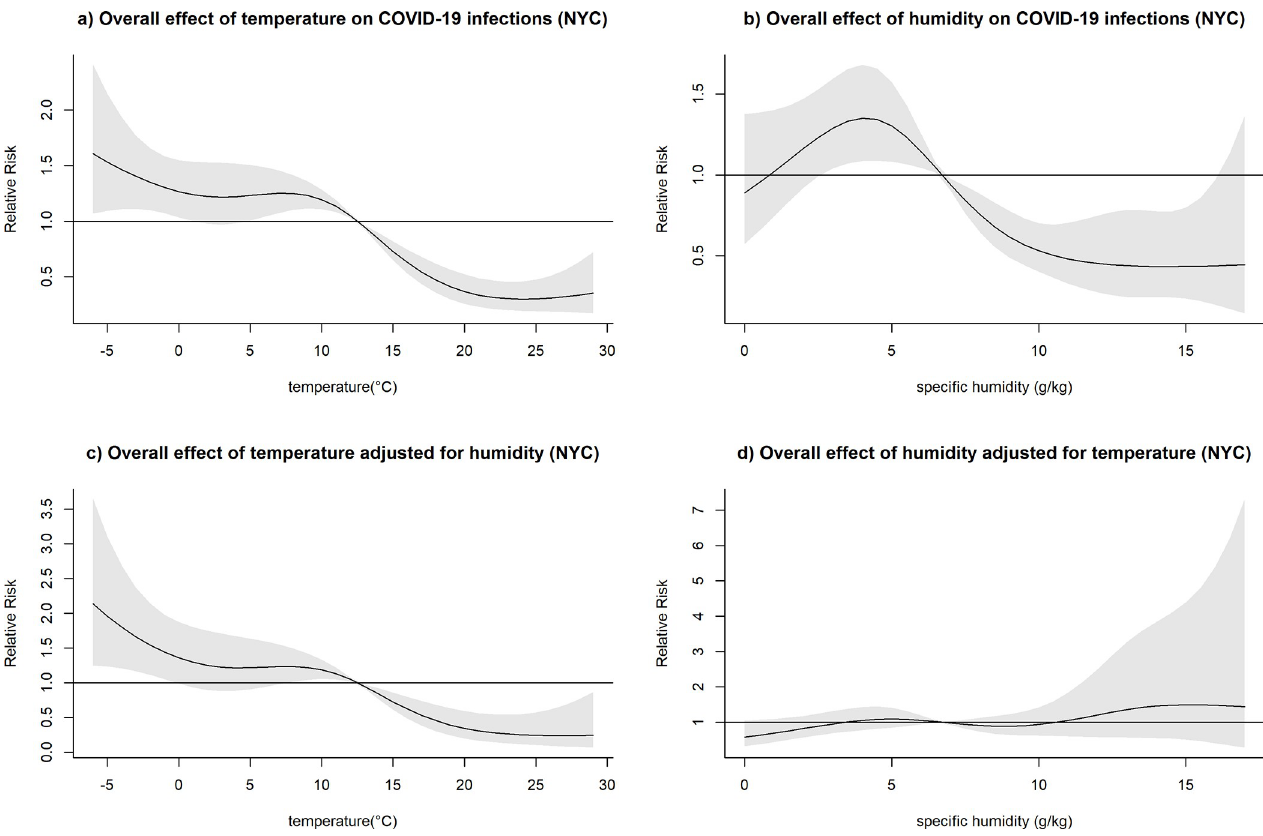
Fig 3. Overall effect of temperature and humidity on COVID-19 infections in NYC. The relative risk of COVID-19 infection was plotted across the range of temperature/humidity to show the a) Unadjusted effect of temperature; b) Unadjusted effect of humidity; c) Effect of temperature adjusted for humidity; d) Effect of humidity adjusted for